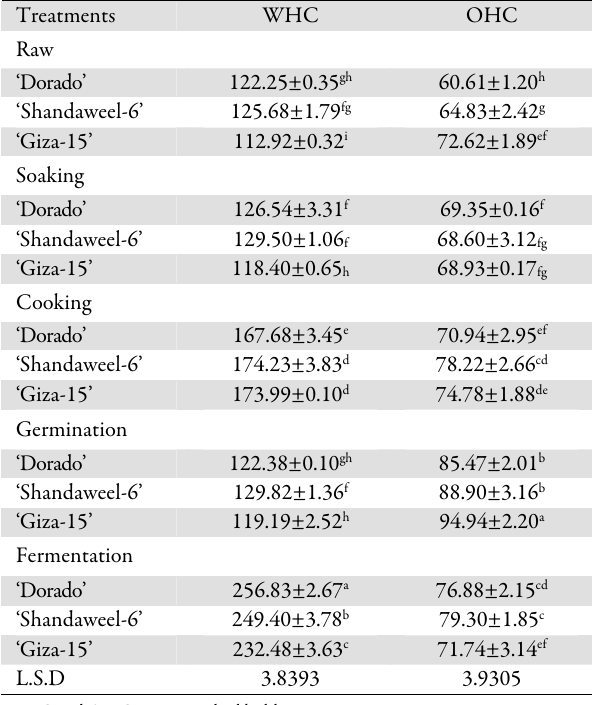
Table 1. Physical properties of sorghum varieties 1000 kernel Varieties